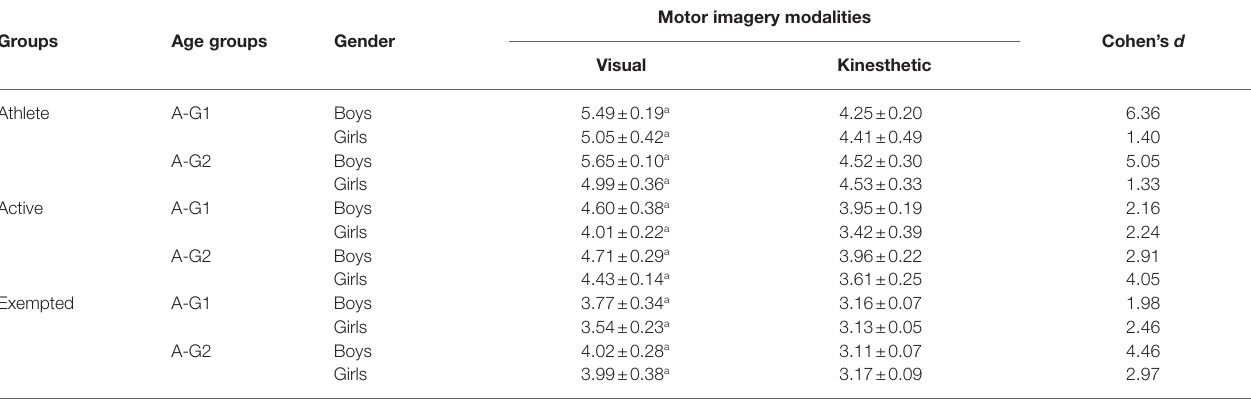
TABLE 3 | Sport and physical practice effect on motor imagery vividness.